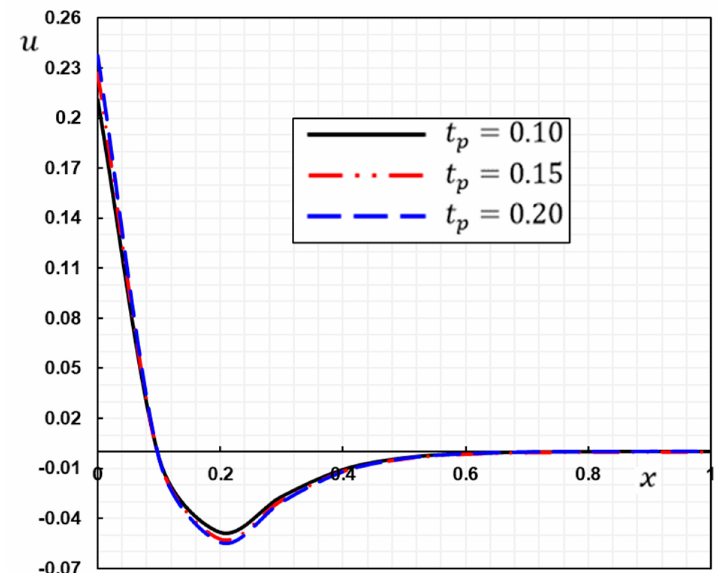
Figure 5. Variation of displacement u against laser pulse duration t p .